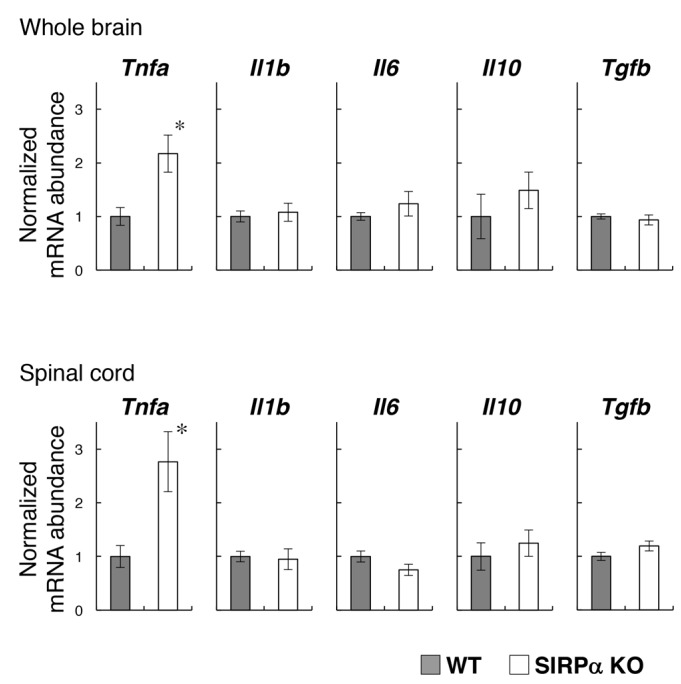
Expression of pro- and anti-inflammatory cytokines in the brain and spinal cord of SIRPα KO mice.Whole brains and spinal cords were dissected from WT or SIRPα KO mice at 13–20 wks of age for the isolation of total RNA. The expressions of the indicated cytokines were then determined by quantitative polymerase chain reaction (PCR) analysis. The amount of each mRNA was normalised to that of glyceraldehyde-3-phosphate dehydrogenase (GAPDH) mRNA and is presented relative to the mean value for control WT mice. Filled and open bars indicate WT and SIRPα KO mice, respectively. Data are the means ± SEM (n = 6 mice for each genotype). *p<0.05 (Welch’s t-test).